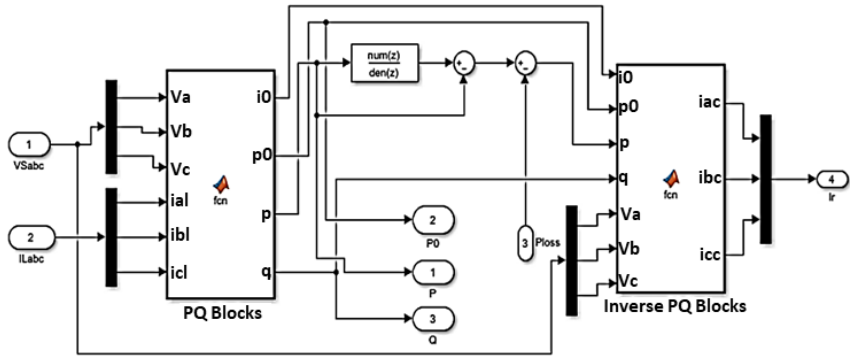
Figure 10. SIMULINK Design for PQ-theory Control Algorithm.